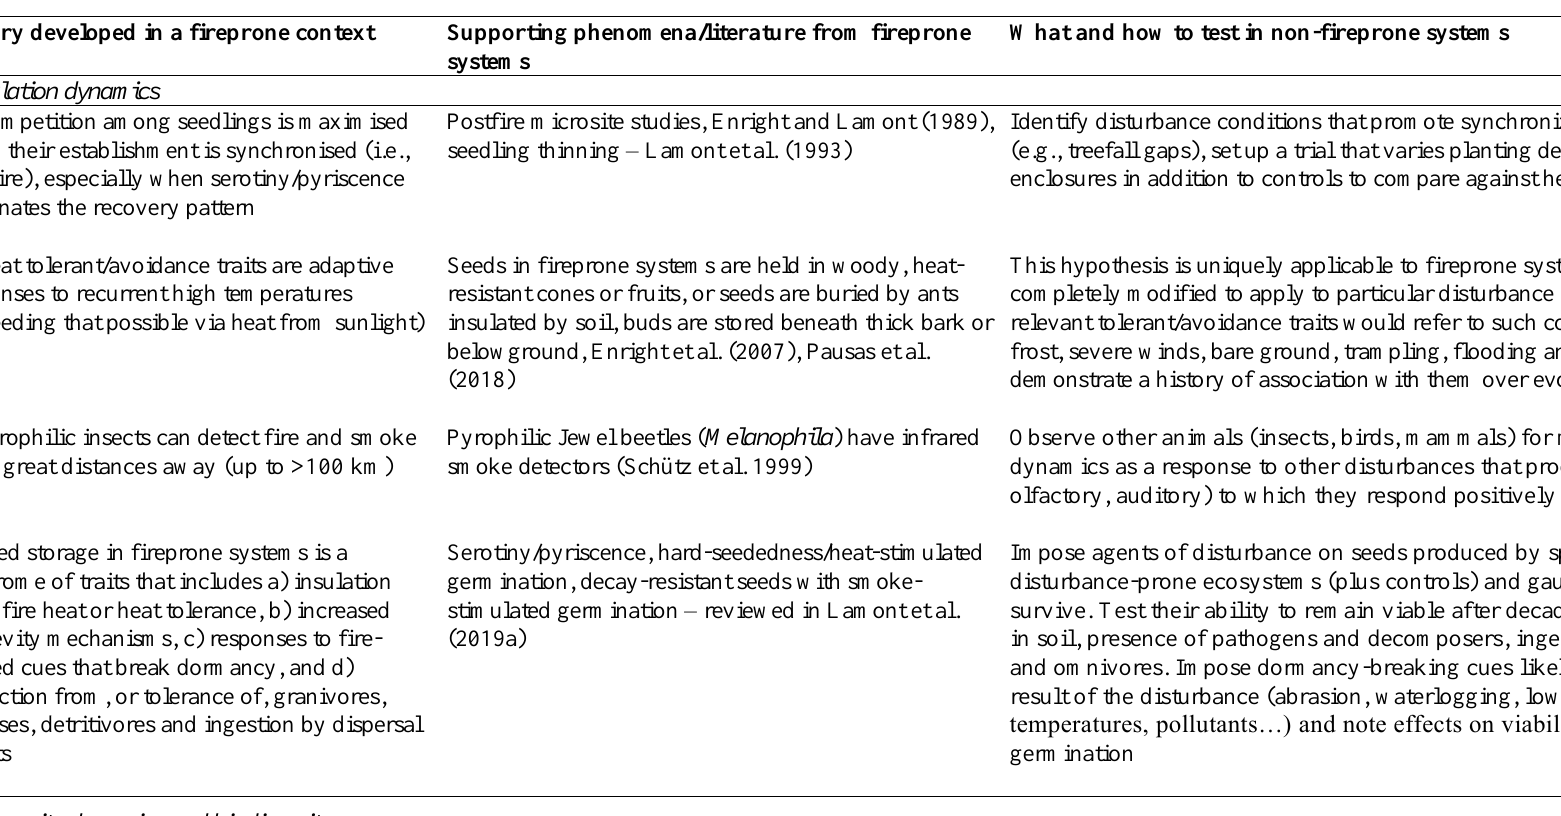
Table 2. Twenty theories and models that were developed for fireprone systems that could be applied to non-fireprone systems (or fireprone that also undergo disturbances from causes other than fire) to gauge their applicability and generality. Unless cited elsewhere in the text, references cited in this table are listed at the end of Appendix Table